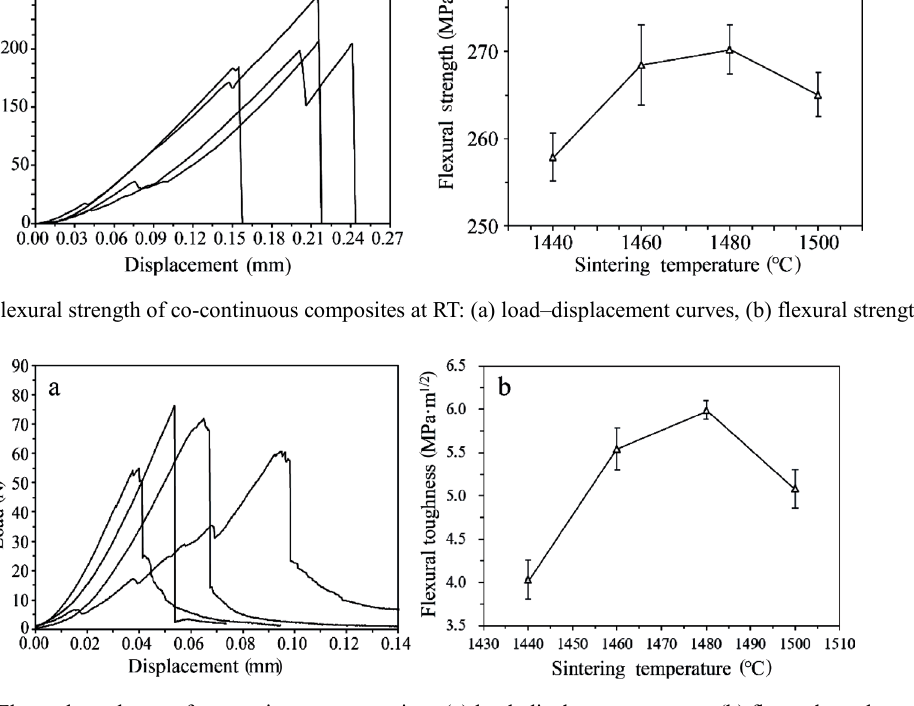
Fig. 8 Flexural toughness of co-continuous composites: (a) load–displacement curves, (b) flexural toughness.